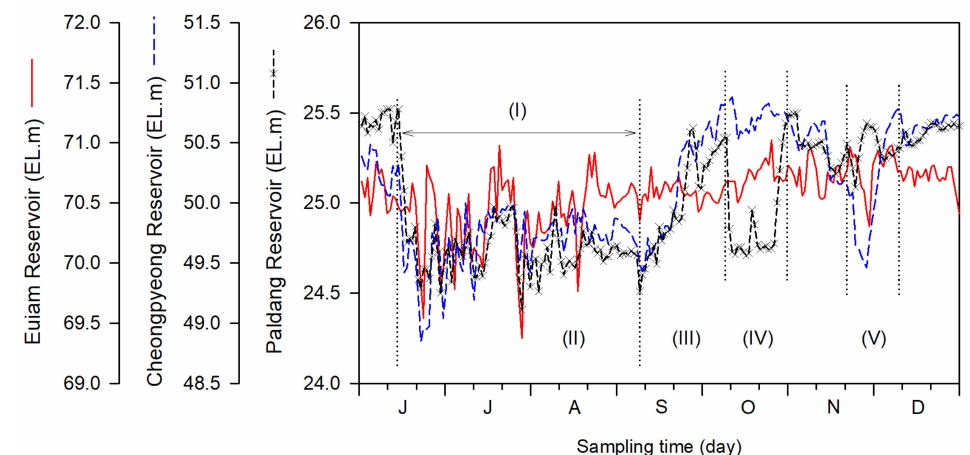
Figure 3. Comparison of daily water-level fluctuations (WLFs) in the Euiam and Cheongpyeong Reservoirs of the North Han River and Paldang Reservoir of the Han River from June to December 2011. The spillway discharging periods of the three reservoirs occurred simultaneously from 27 July to 5 August 2011. (I) Impound and discharge (II) Bloom potential (III) Proliferation of cyanobacterial bloom (IV) 1st transport and dispersion to Cheongpyeong Reservoir (V) 2nd transport and dispersion to Paldang Reservoir.